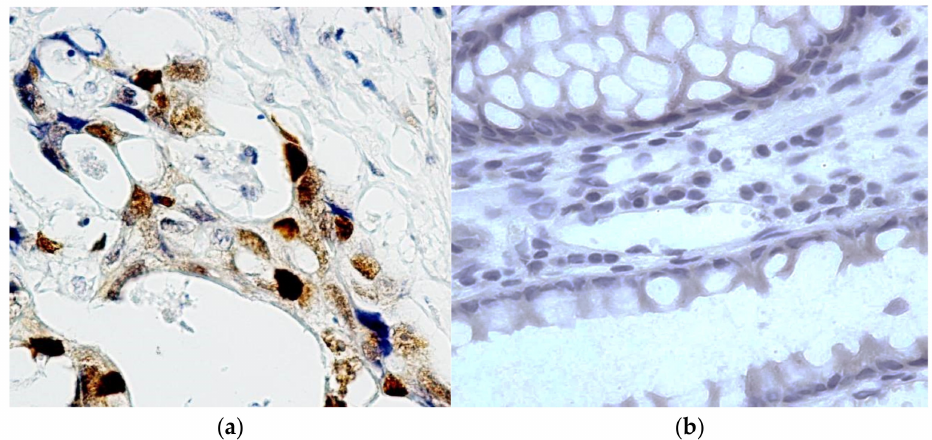
Figure 1. Immunohistochemical reaction with antibodies to p53 in adenocarcinoma and in the tumor resection region. ( a ): the expression of p53 is moderately expressed in RC cell nuclei, in some places sharply expressed; ( b ): the expression of p53 in the resection edge is not determined. Chromogen–diaminobenzidine. Control staining with hematoxylin staining. Magnification: × 400.